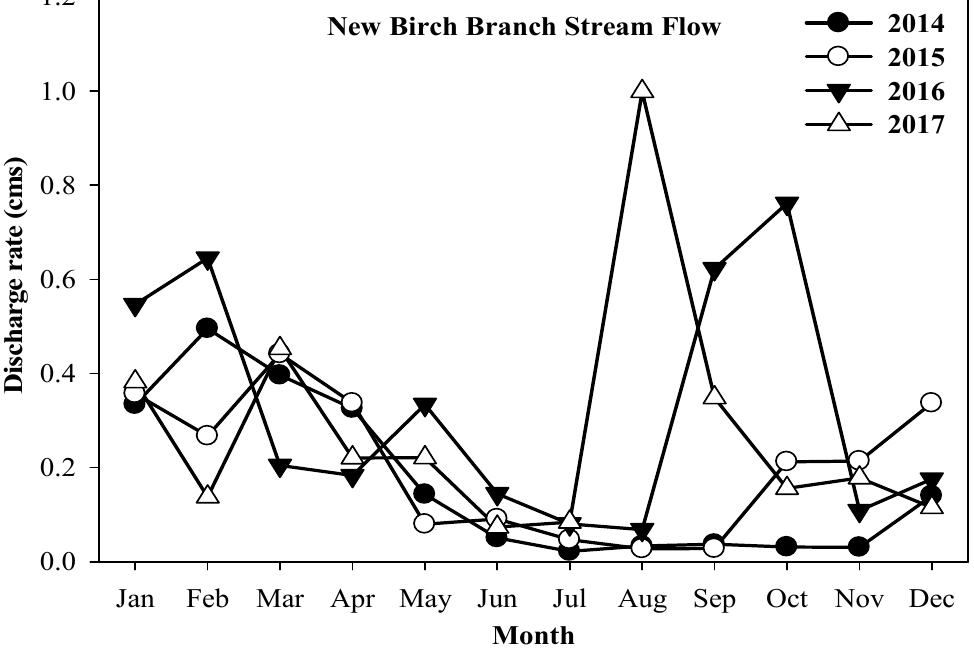
Figure 4. Temporal variation of Birch Branch mean monthly stream flow (cubic meters per second) in 2014, 2015, 2016 and 2017.